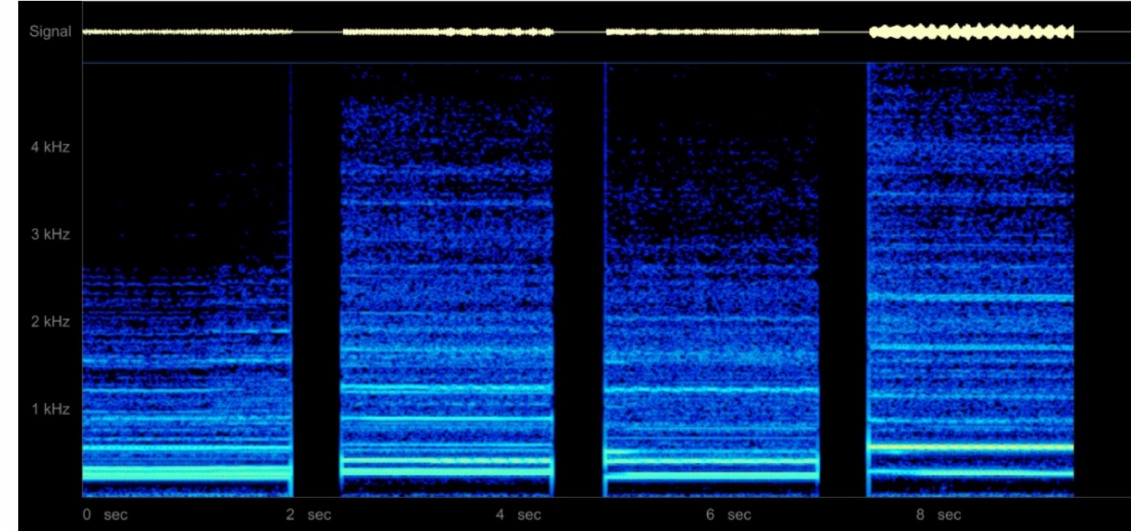
Figure 24. Spectrogram of quadruple flute experimental model from the “Zacuala Palace”, low blowing pressure and fingering positions from left to right: all fingerholes stopped; all fingerholes open; fingerholes of pipes A–B open, pipes C–D stopped; fingerholes of pipes A–B stopped, pipes C–D open (Sample